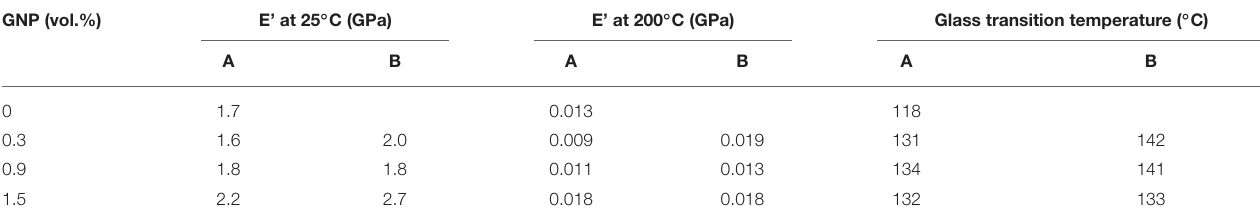
TABLE 2 | Dynamic-mechanical properties of ER/GNP composites as a function of the processing methodology. GNP (vol.%)